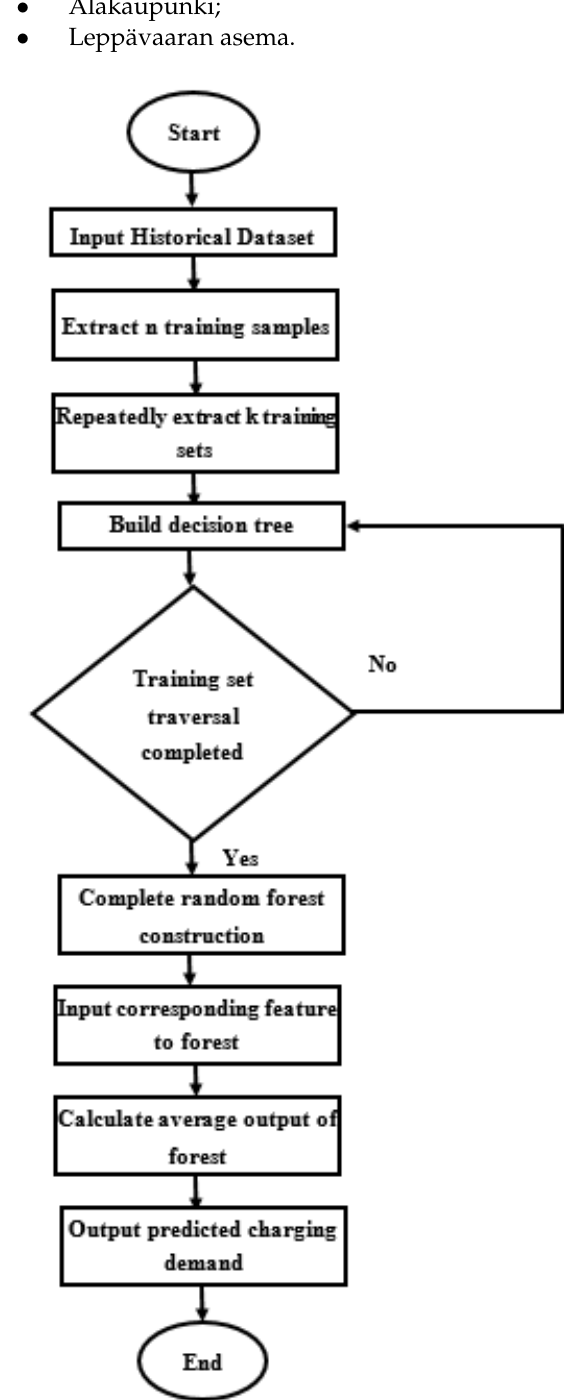
Figure 4. Charging demand prediction by random forest.